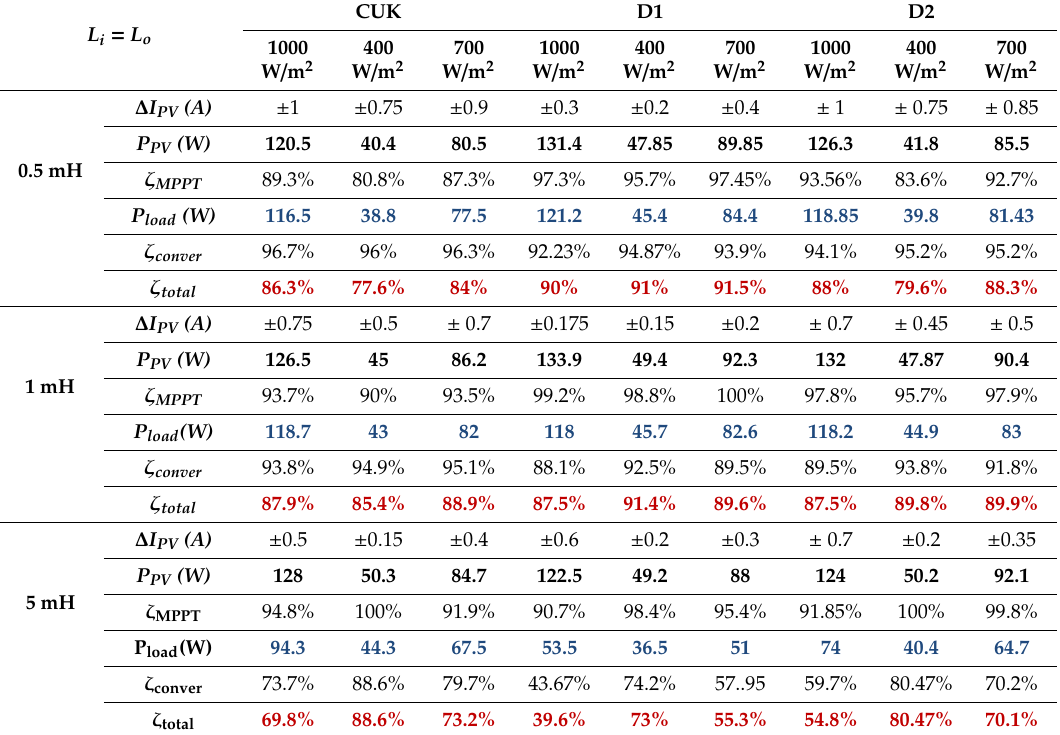
Table 3. Simulation results